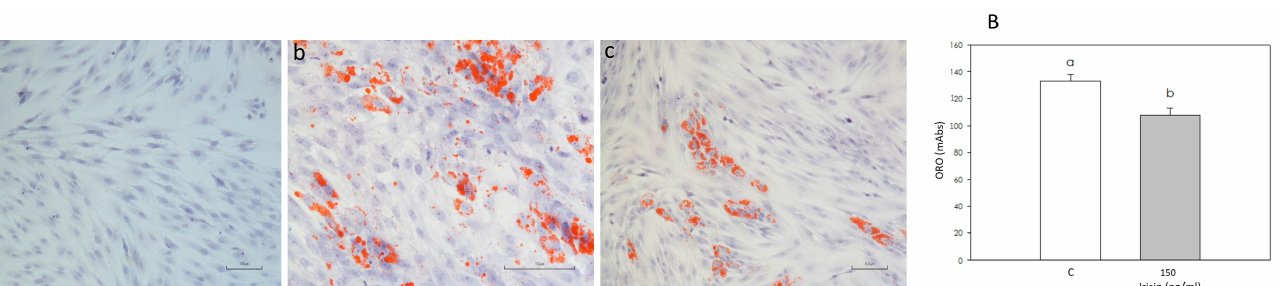
Figure 5. ( Panel A ): Optical microscope images (10×) of ( a ) control adipose stromal cells not differ- entiated, ( b ) adipose stromal cells undergoing adipogenic differentiation in the absence or ( c ) in the presence of Irisin 150 ng/mL, after Oil Red O staining. ( Panel B ): Spectrophotometric quantification (milliAbsorbance; mAbs) after Oil Red O staining of adipose stromal cells undergoing adipogenic differentiation (a) in the absence or (b) in the presence of Irisin (150 nL/mL) has to be changed in differentiation in the absence (C) or in the presence of Irisin (150